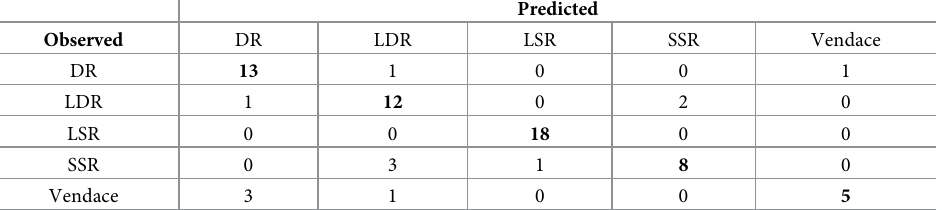
Table 2. Classification table based on a leave-one-out cross validation linear discriminant analysis of select FA in coregonid taxa. Model assumed proportional priors and estimation was based on n = 69 cases. Overall accuracy: